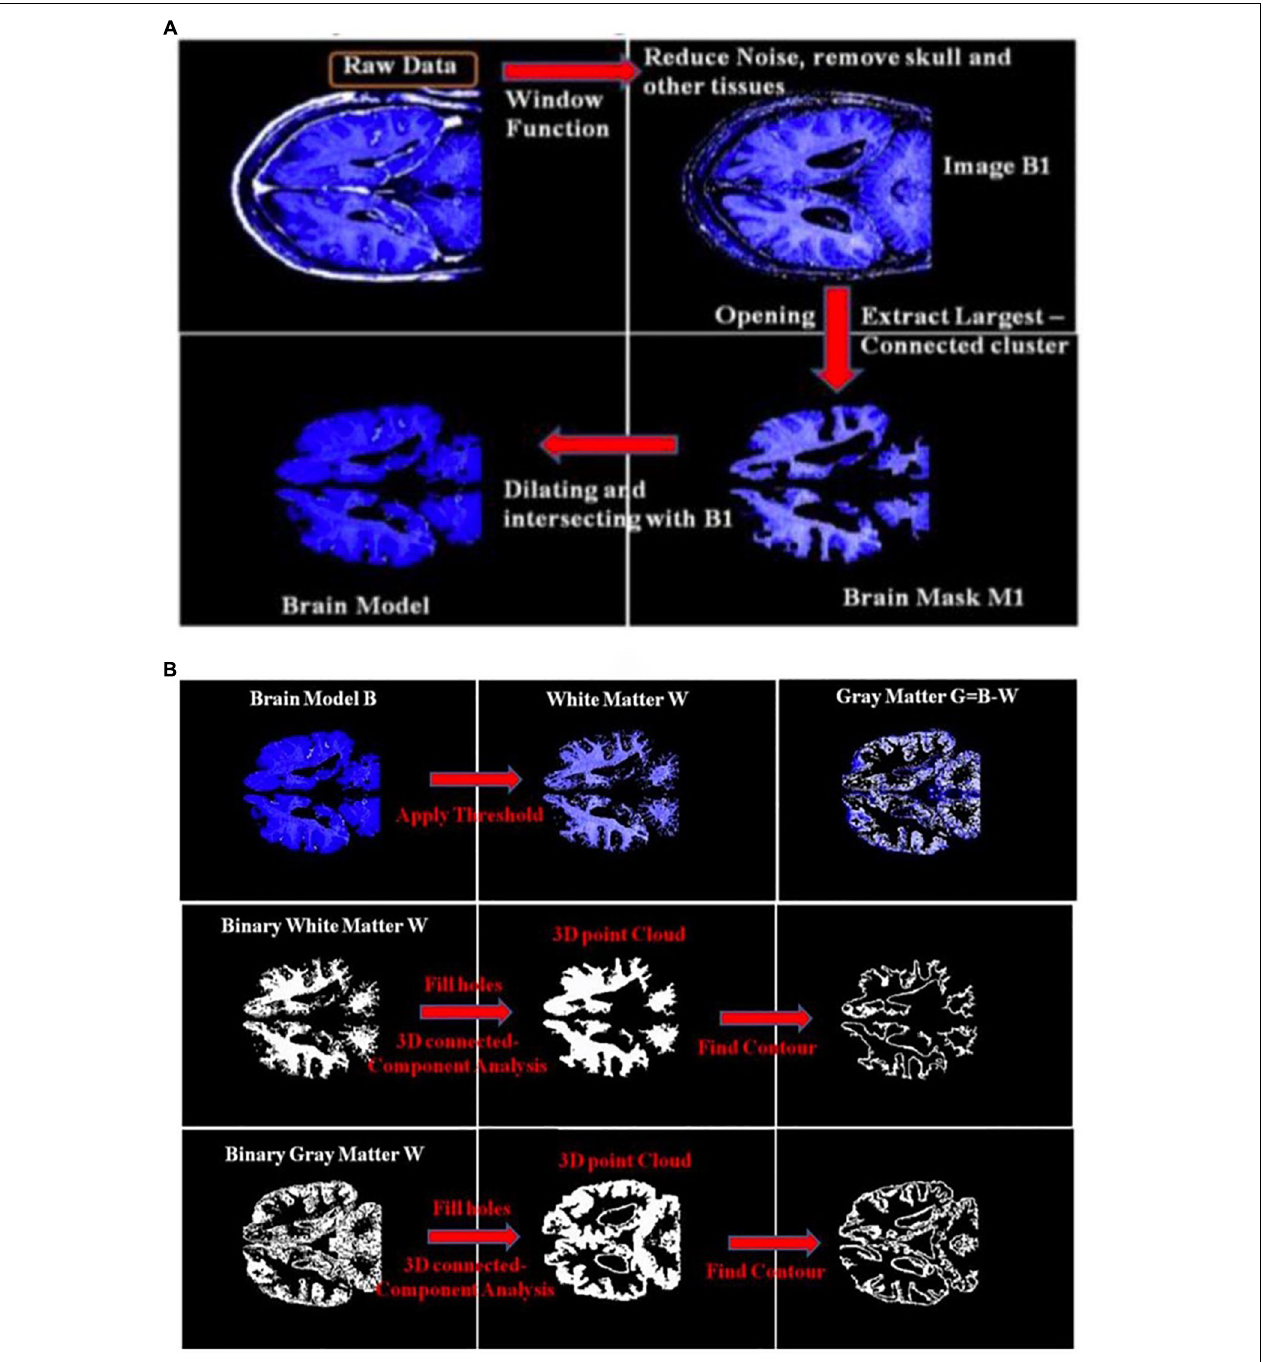
FIGURE 3 | (A) An illustration of the process of obtaining a brain model using an MRI image; (B) an illustration of the process to obtain the 3D point clouds and surface contours of the white matter and gray matter from the extracted brain model. B1, Background Image 1; M1, Brain Mask 1.